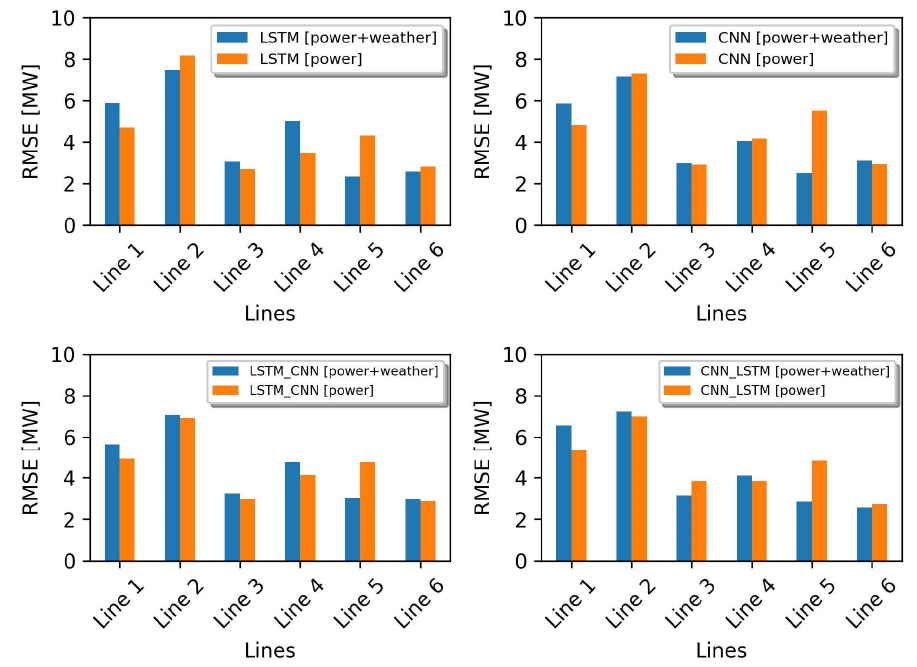
Figure 11. Performance comparison based on the RMSE metric.